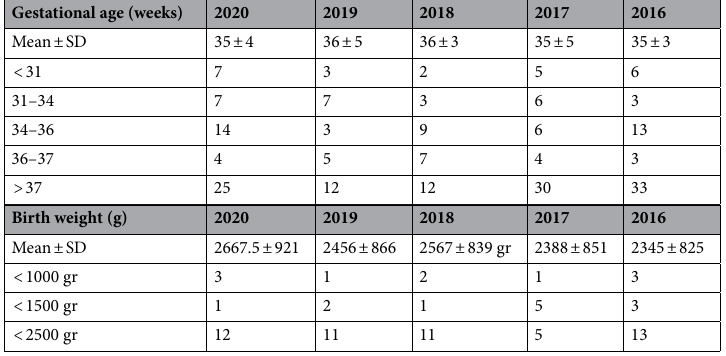
Descriptive statistics were calculated for all clinical variables. Qualitative variables are represented as a per- centage and quantitative variables as mean ± standard deviation. Kolmogorov–Smirnov One-Sample Test and statistics were used for testing normal distribution of quantitative variables.